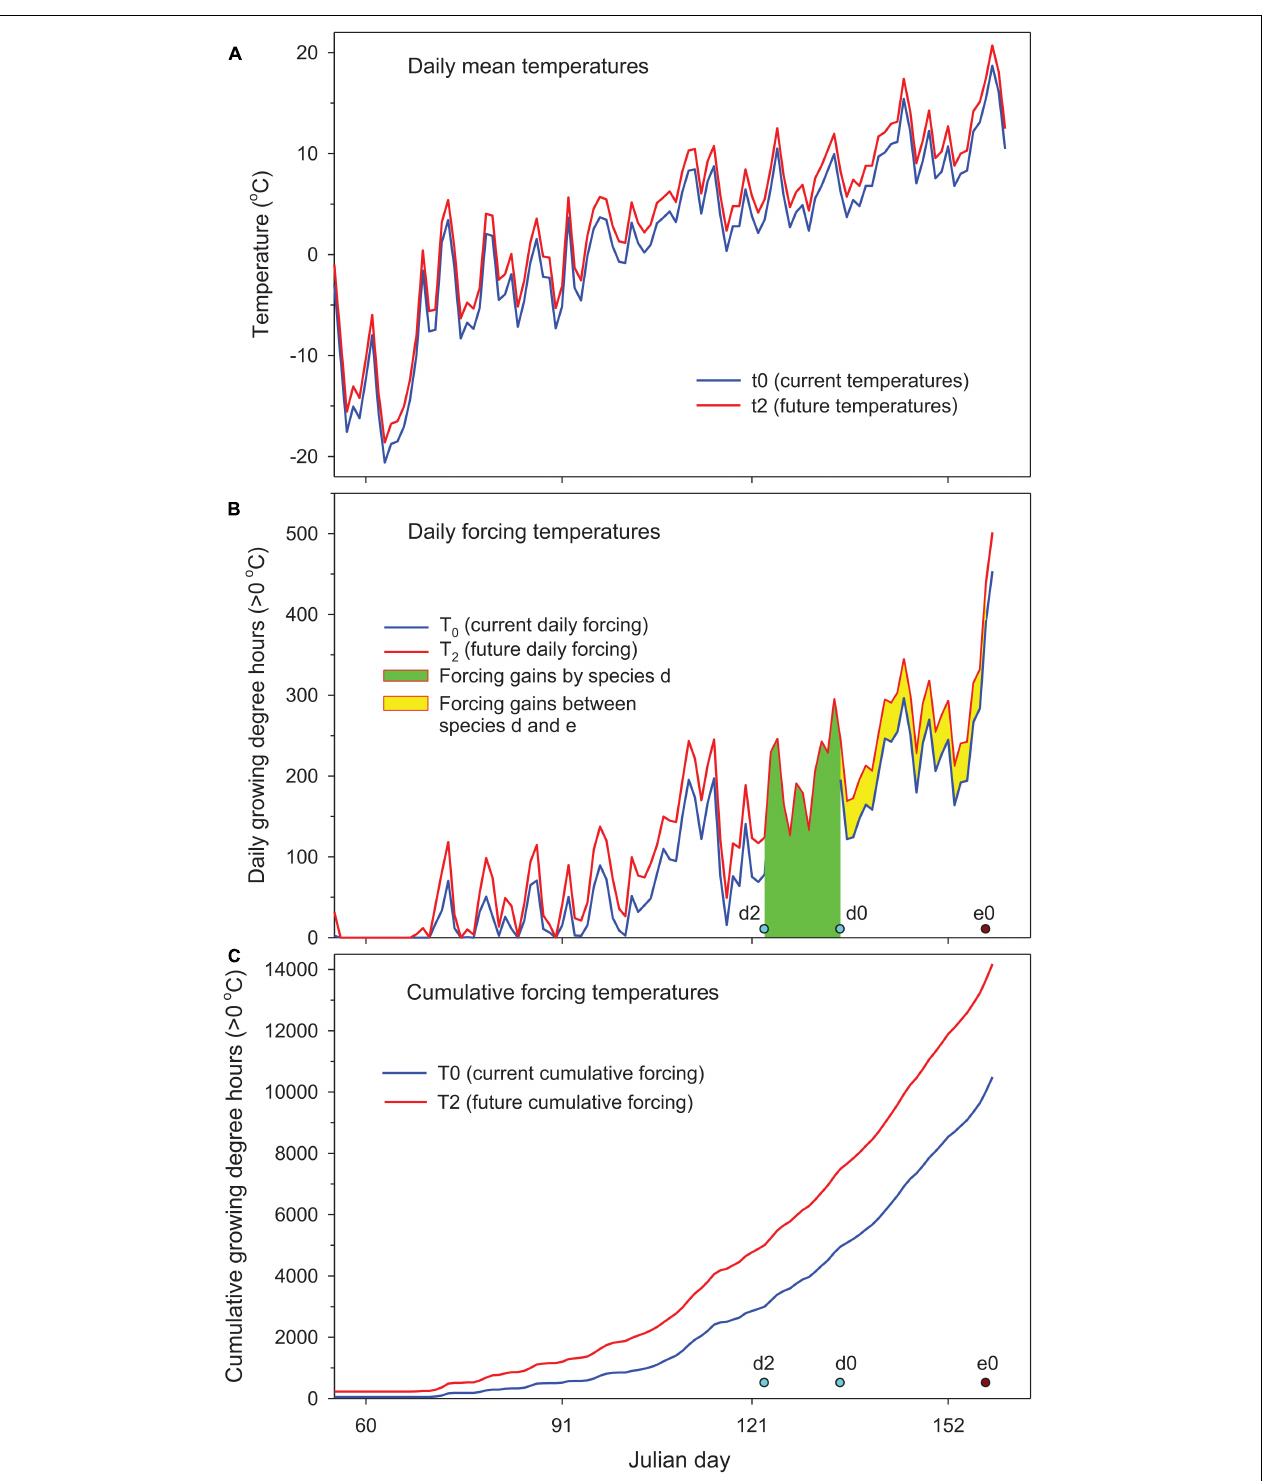
FIGURE 1 | Quantification of species response to climate warming (2 ◦ C uniform warming) for hypothetical species d (forcing requirement = 5,000 cumulative growing degree hours (CGDH > 0 ◦ C) since January 1 at leaf-out date d0 and d2 under current and future warmer conditions) relative to reference species e (10,000 CGDH at e0) using 2018–2019 winter temperatures in Sault Ste Marie, Ontario, Canada, (A) mean daily temperatures, (B) daily forcing temperatures showing forcing gains by species d (Equation 4 in “Materials and Methods”) and forcing gains that occur between subject species d and reference species e (Equation 5 in “Materials and Methods”), and (C) cumulative forcing temperatures (see Table 1 for more